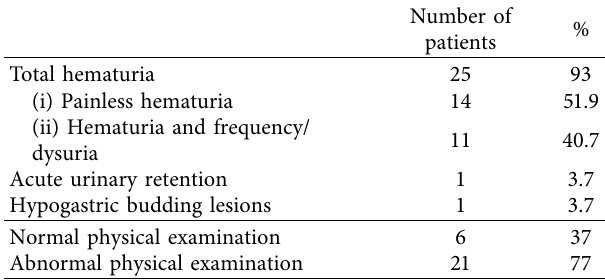
Table 1: Presenting symptoms and physicals examinations’ results.